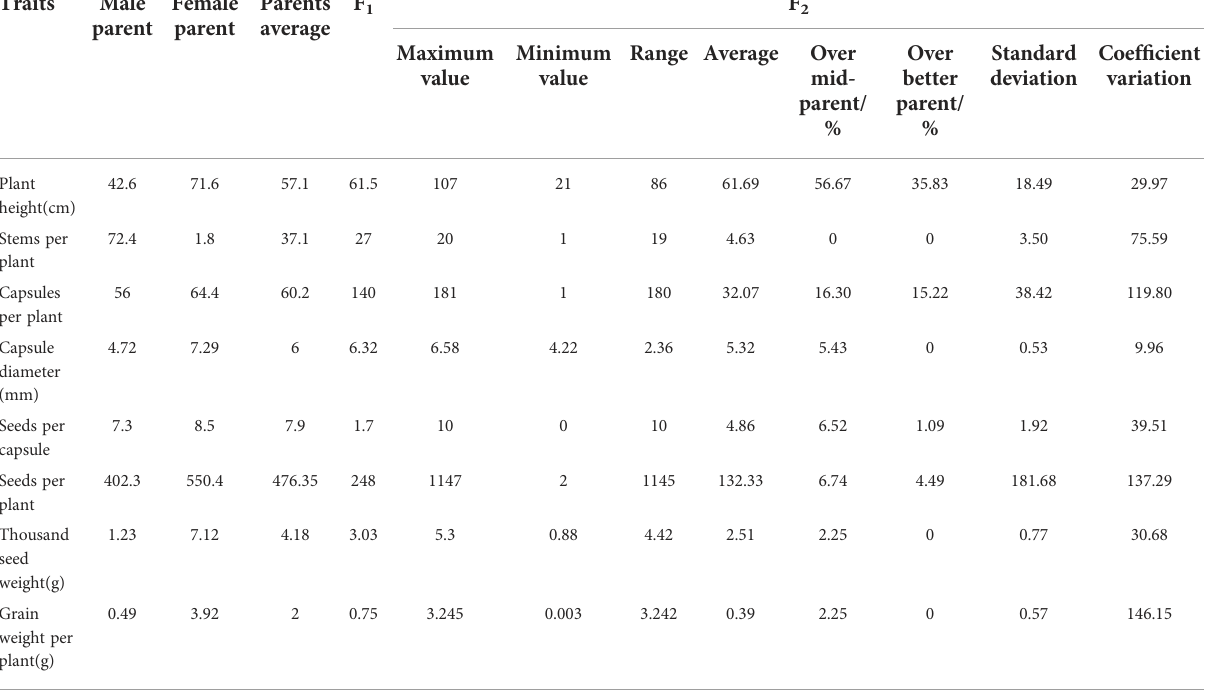
TABLE 2 Single plant trait of hybrids obtained from Longya-10×pale fl ax.